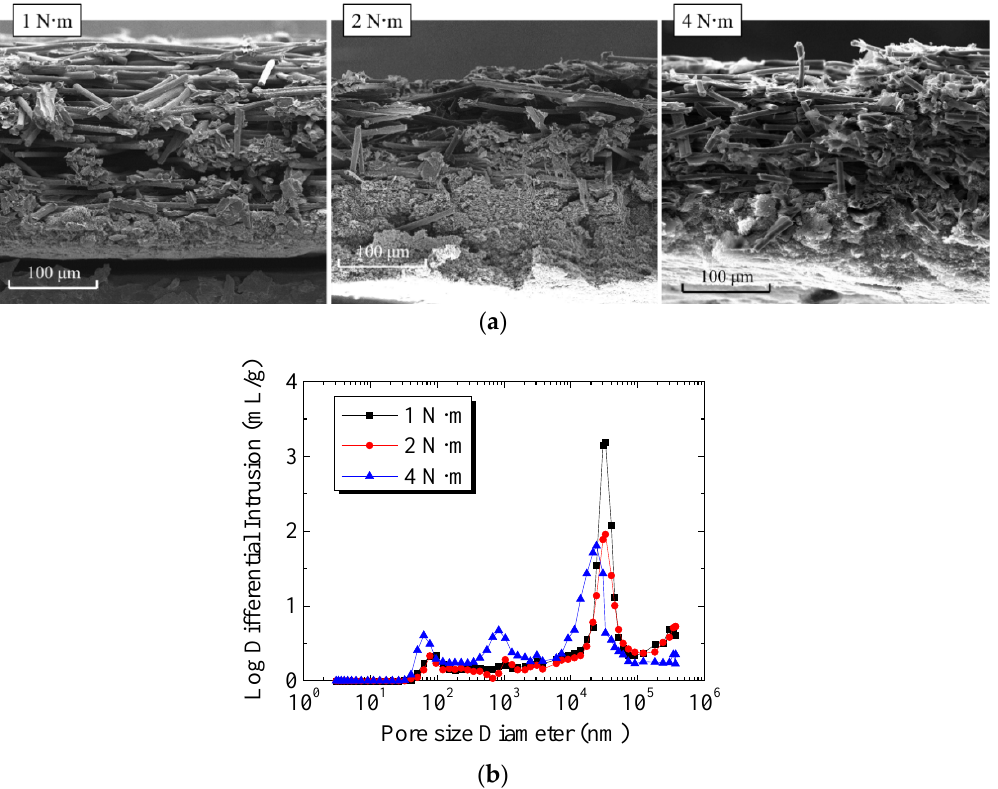
Figure 5. Features of microstructure and pore in GDL and MPL at different assembly pressures: ( a ) Cross-section of GDL at different assembly pressures; ( b ) Pore size distribution of GDL and MPL at different assembly pressures.